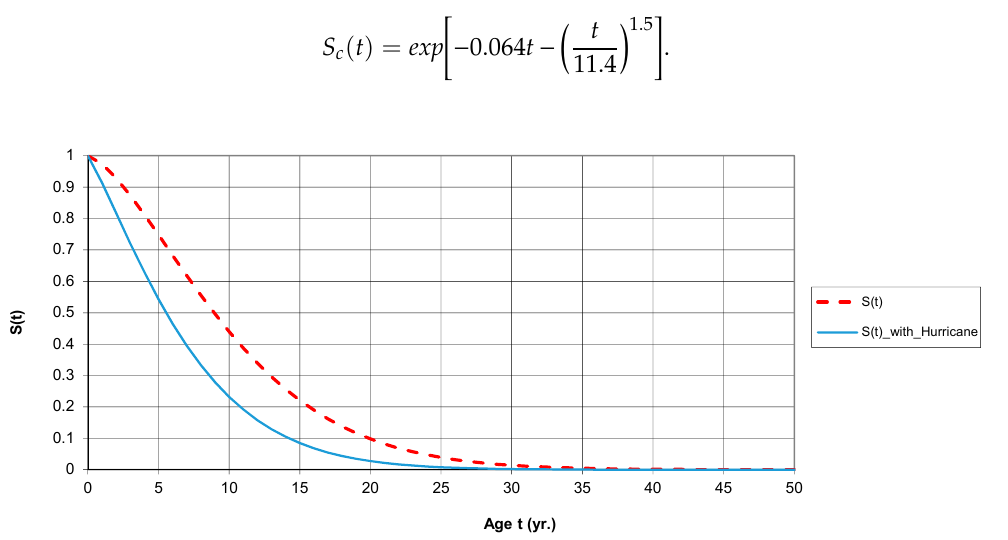
Figure 11. Survivor curves of CAV elements in the presence of a hurricane hazard.